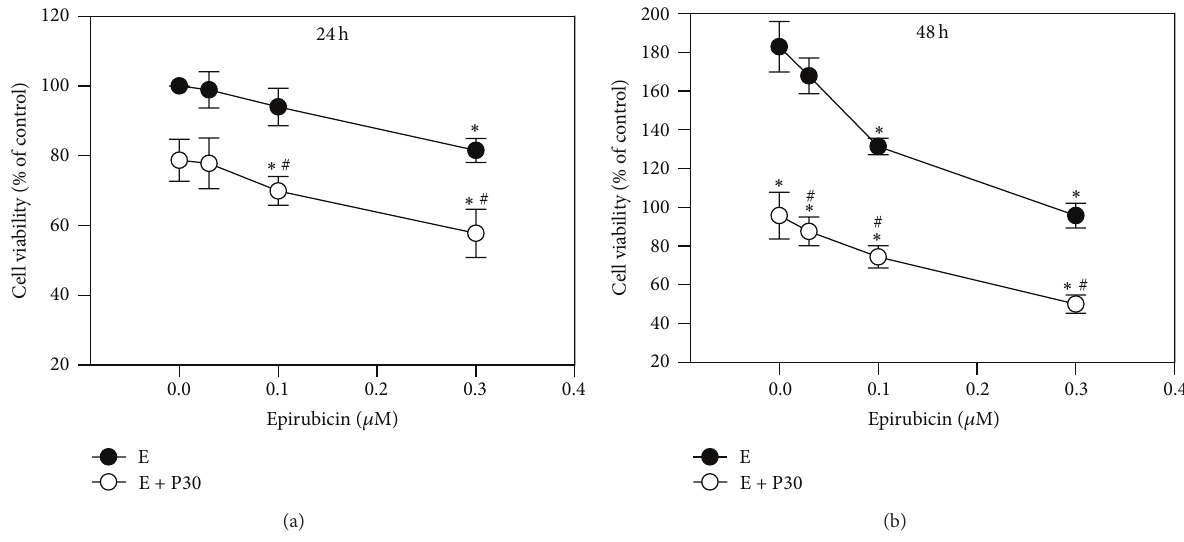
Figure 1: Effects of epirubicin on cell growth without or with progesterone addition. HA22T/VGH cells were treated with different concentrations of epirubicin without or with 30 𝜇 M progesterone for 24 h (a) or 48h (b). Results are expressed as the mean ± standard deviation (S.D.) for three separate experiments. E: epirubicin; P30: 30 𝜇 M progesterone. ∗ 𝑃 < 0.05 compared to the corresponding untreated controls. # 𝑃 < 0.05 compared to the corresponding epirubicin-treated